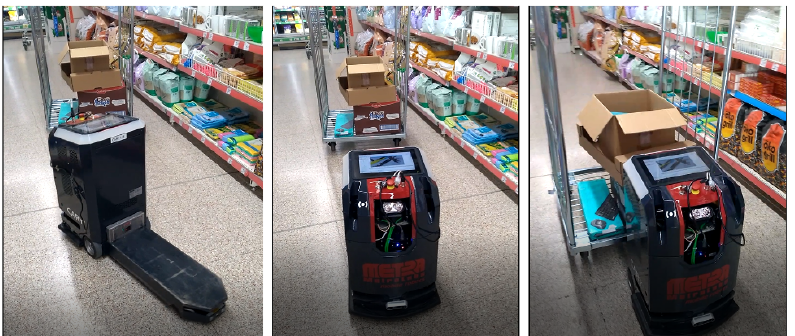
Figure 5. The CARY robot approaches to a roll container, picks it up, and moves the container towards a new